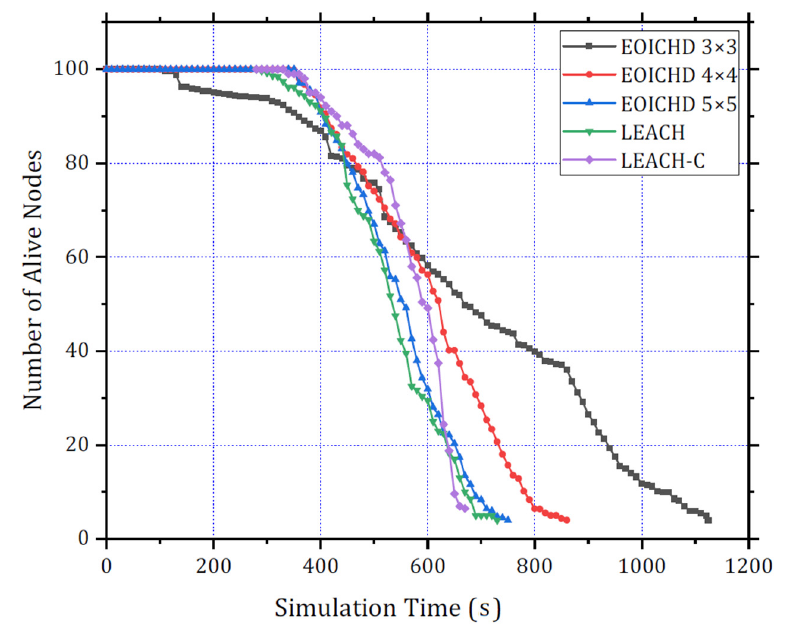
Figure 8. Number of alive nodes over simulation period Scenario #2. Figure 8